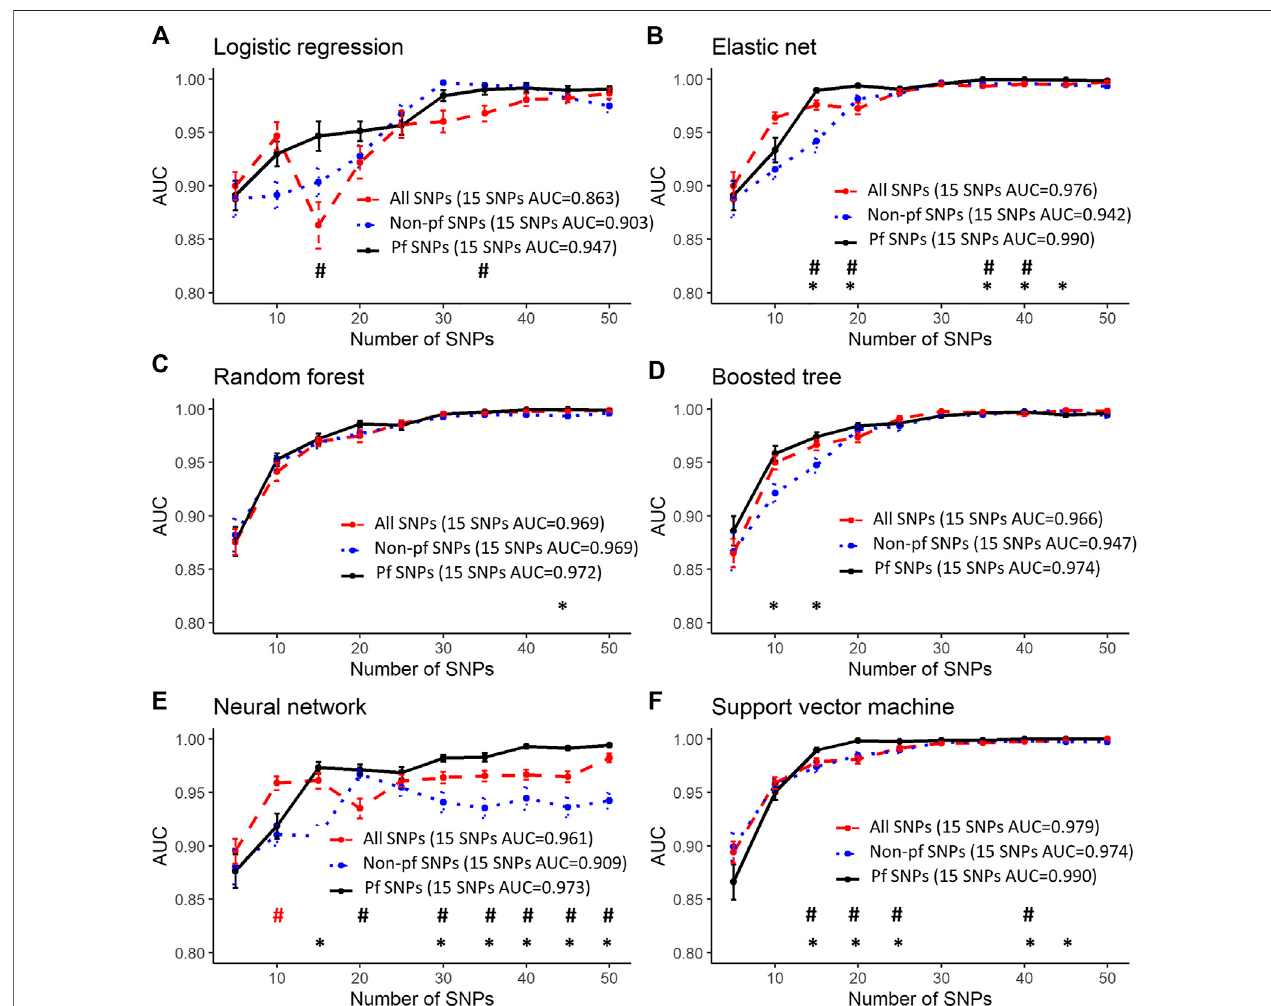
FIGURE 2 | Predictive performance using the top 5 to 50 SNPs most associated with myalgia from our dataset. Error bars denote the standard error of the mean. # ’ s indicate statistical signi fi cance when comparing between all SNPs and pfSNPs while * ’ s indicate statistical signi fi cance when comparing between non-pf SNPs and pfSNPs.Statisticalsigni fi cancewhencomparingbetweenallSNPsandnon-pfSNPsisnotshown.ThecolorsrepresenttheinputsetwiththehigherAUC(red — allSNPs, blue — non-pf SNPs and black — pfSNPs). Bonferroni corrected unpaired t -test p -values ( p < 0.05) were used for determining statistical signi fi cance.